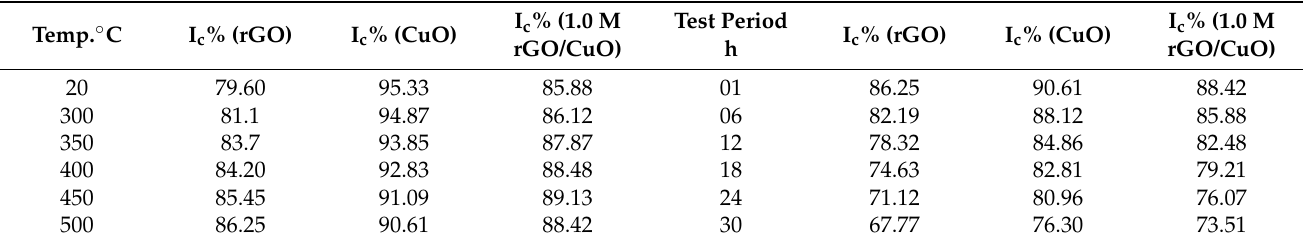
Figure 2. Variation of I c /temperature at rGO, CuO, and 1.0 M rGO/CuO and 1 h. Table 1. Effect of temperature and test period on crystallinity index (I c ) of rGO, CuO and 1.0 M rGO/CuO.